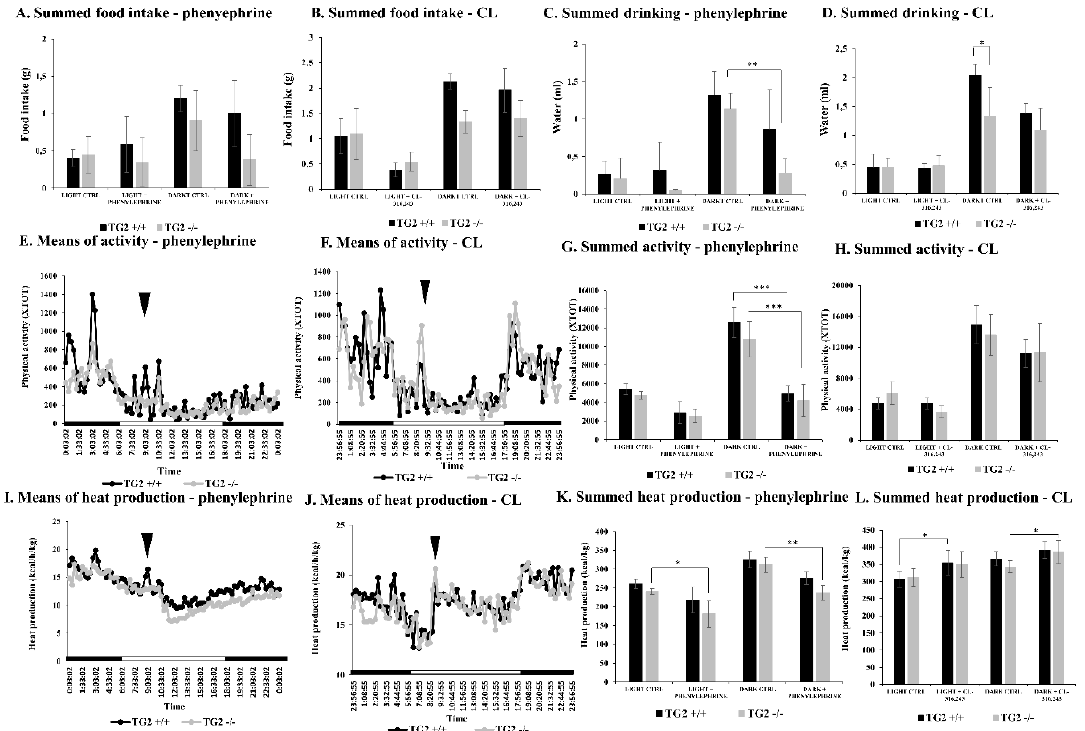
Figure 1. Alpha1 but not beta3 adrenoreceptor (AR) agonist treatment leads to decreased physical activity in both TG2 +/+ and TG2 -/- mice. Total ( A , B ) food intake and ( C , D ) water consumption are shown before (CTRL) and after ( A , C ) phenylephrine or ( B , D ) CL-316,243 (CL) treatment for both in the light (9:03 a.m.–6:00 p.m.) and the dark (6:01 p.m.–6:00 a.m.) periods. Mean values of physical activity are presented before and after ( E ) phenylephrine and ( F ) CL treatments. Arrowheads show the time point (9:00 a.m.) when the compounds were injected intraperitoneally (60 nM / g body weight). Day ( (cid:3) ) and night ( (cid:4) ) periods are indicated on the “X” axes ( n = 6). Total physical activity is also presented for ( G ) phenylephrine and ( H ) CL investigations before (CTRL) and after the treatments both in the light and dark periods. ( I , J ) Mean values of heat generation and ( K , L ) total heat generation are shown for ( I , K ) phenylephrine and ( J , L ) CL experiments. Columns represent the mean values ± SD ( n = 6). Statistical analyses were carried out using GraphPad Prism 7.0 version, by two-way ANOVA (Tukey’s multiple comparison test; * p < 0.05, ** p < 0.01 and *** p <